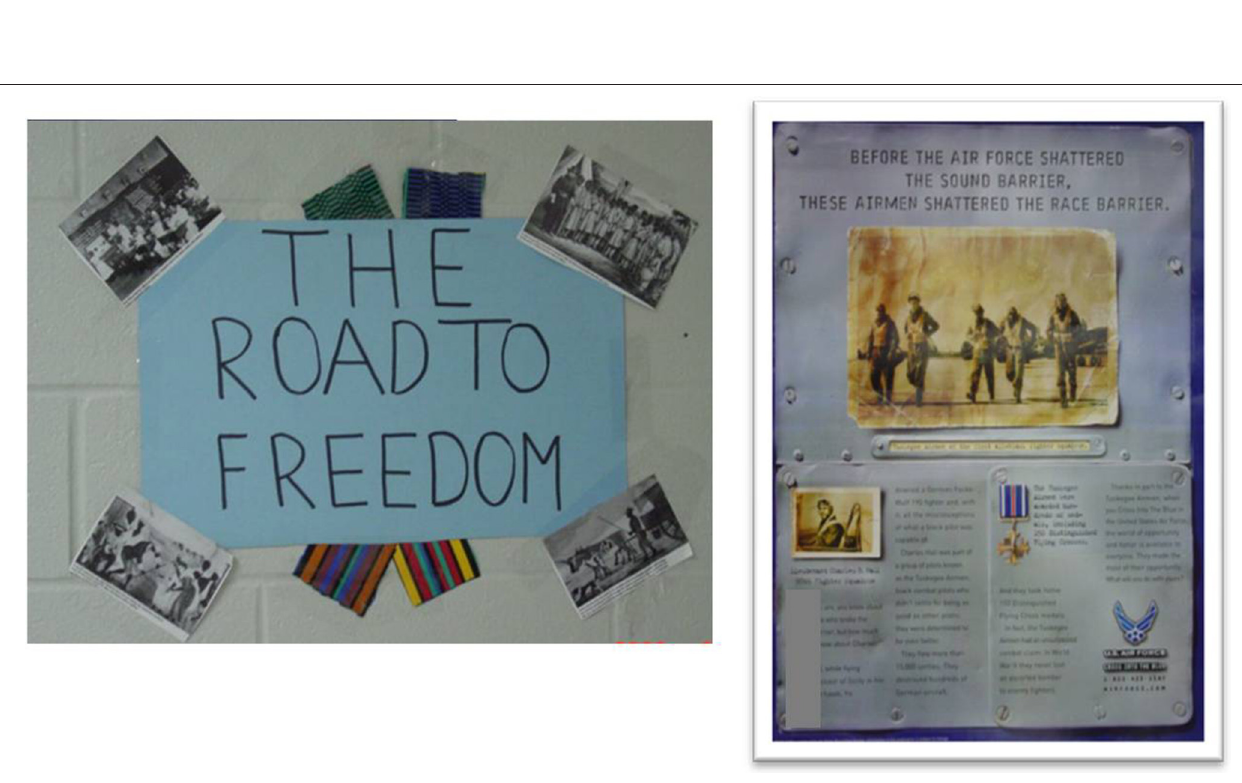
Frontiers in Psychology |